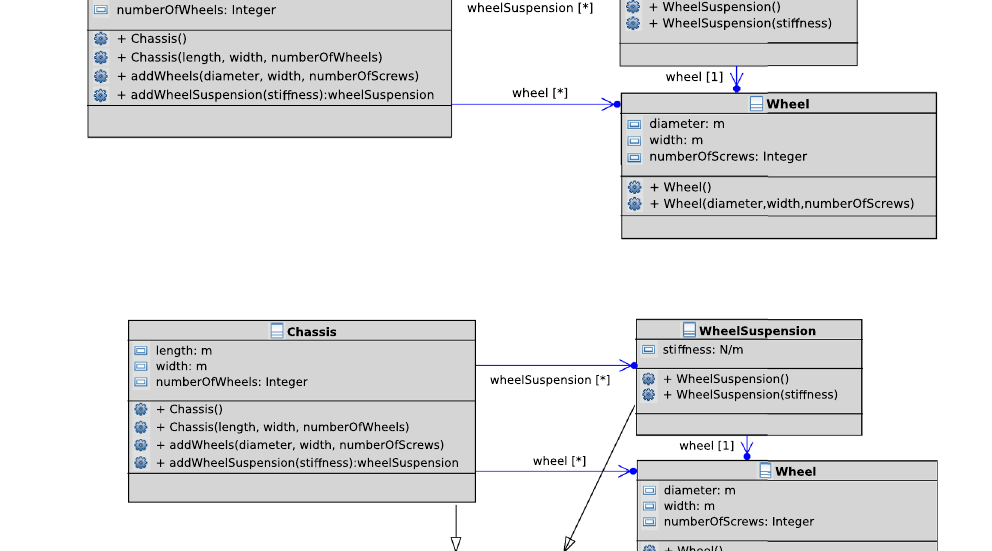
Fig. 8 Top: Calling method addWheelSuspension that returns an instance method- Return which is integrated in the model on the RHS. Bottom: An instance of type Wheel is created and linked to the exist- ing Chassis instance on the RHS by calling the